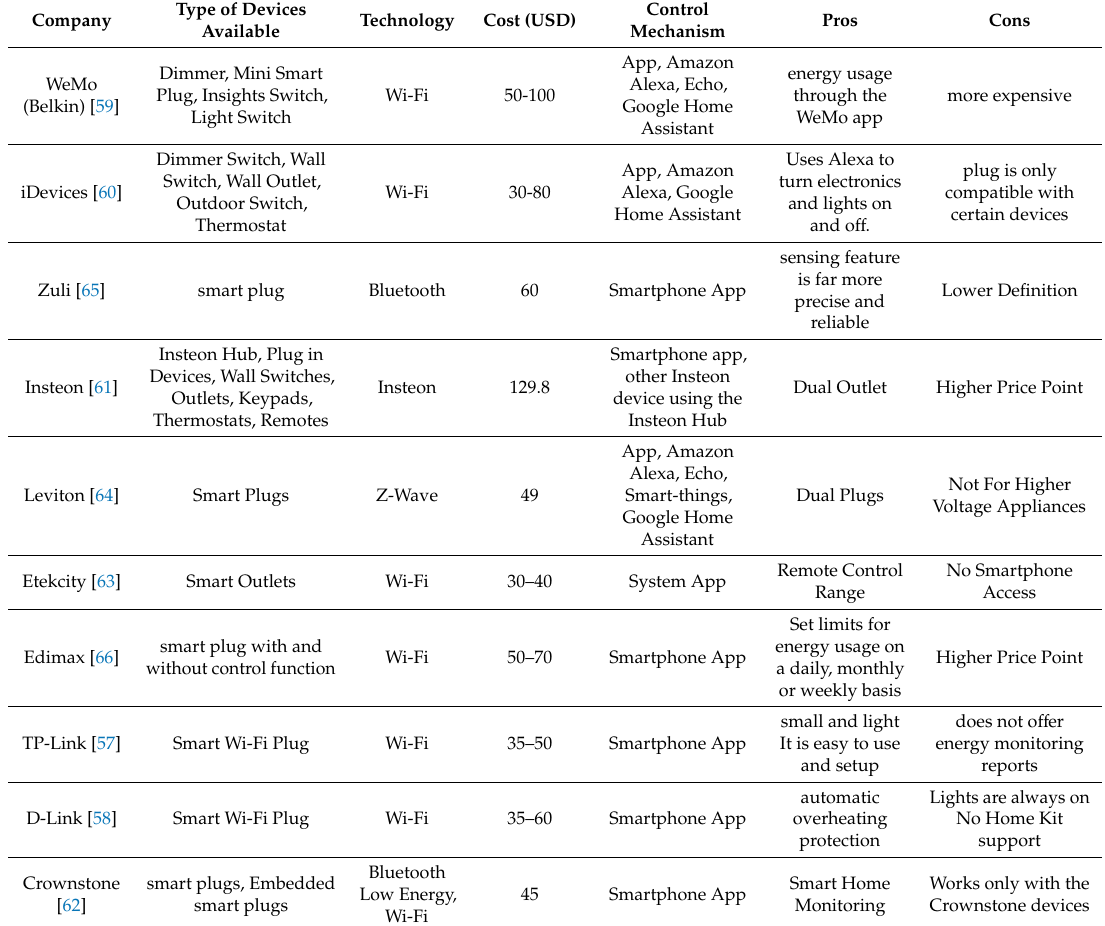
Table 2. Summary of commercially available smart